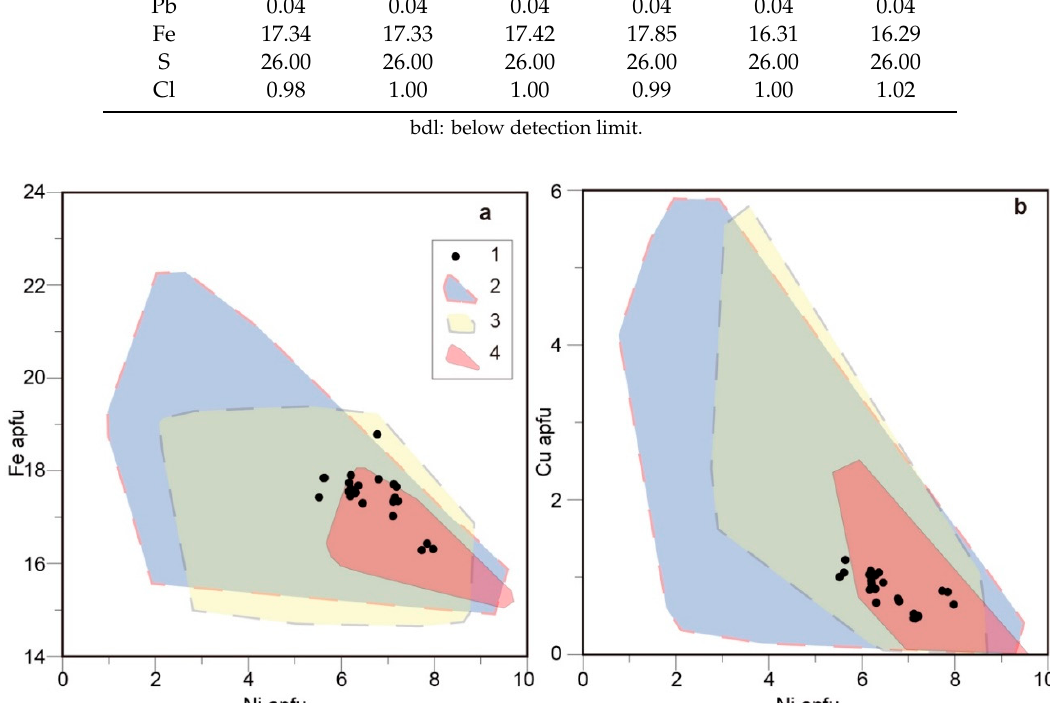
Figure 6. Chemical composition of the three different rutile types described in this work for the studied Menominee samples. ( a ) TiO 2 –Cr 2 O 3 plot (composition fields are according to [24]). Domain labeled “a” corresponds to rutile from cratonic deep-seated magmatic rocks, domain “b” to rutile from off-craton alkali basalts, and domain “c” to groundmass rutile from kimberlites. ( b ) Cr 2 O 3 –Nb 2 O 5 plot. Domain labeled 1 corresponds to rutile from the xenogenic material of kimberlites of South Africa [25]; domain 2 to rutile in metasomatic nodules from the kimberlites of the Orapa pipe, Botswana [25]; domain 3 to rutile inclusions in pyrope from Garnet Ridge [26]; and domain 4 to rutile inclusions in pyrope from the Internatsionalnaya pipe [27].